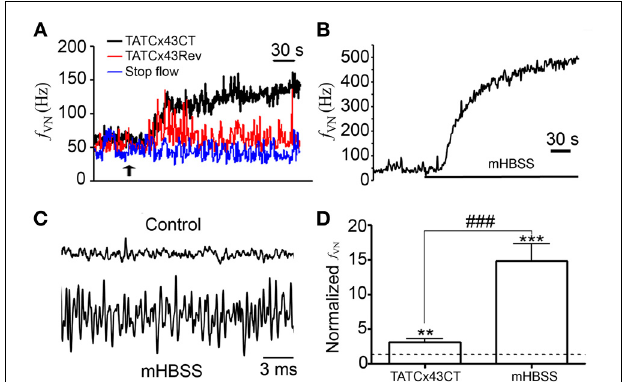
FIGURE 3 | TATCx43CT and mHBSS enhance the neuronal activity of rat NPJcs. Rat NPJc were placed in a recoding chamber superfused with Hanks’ solution (HBSS) and the frequency of discharge was measured in the vagus nerve ( f VN ). (A) Effect of (10 μ L) (black arrow) 100 μ M TATCx43CT (black trace) or 100 μ M TATCx43Rev (red trace) applied to NPJcs ex vivo on f VN . Stop-flow technique did not modify the basal frequency of discharge (blue trace). (B) f VN recorded before and during (indicated by continuous line) superfusion with mHBSS. (C) Spontaneous activity recorded under control conditions (upper trace) and during superfusion with Ca 2 + /Mg 2 + -free HBSS (mHBSS; lower trace). (D) Graph showing the normalized effect of TATCx43CT ( n = 9) and mHBSS ( n = 21) over the electrical activity of NPJcs compared with control conditions (dashed line). Statistical significances; ∗∗ P < 0 . 01 and ∗∗∗ P < 0 . 001 different compared with the basal (pre stimulus) condition, ### P < 0 . 001 between stimuli. Wilcoxon matched-pairs signed rank